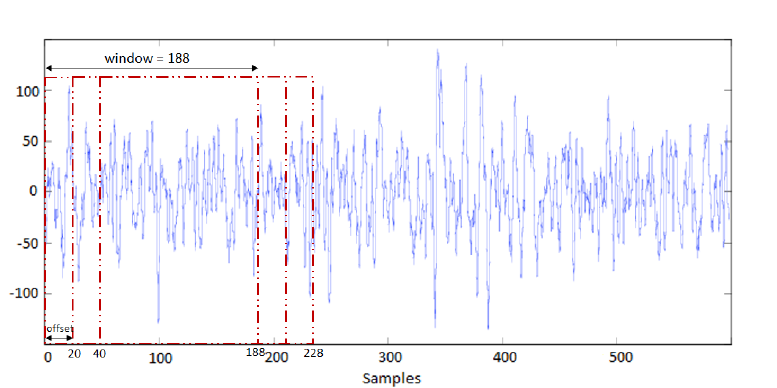
Figure 5. Window method implemented on input